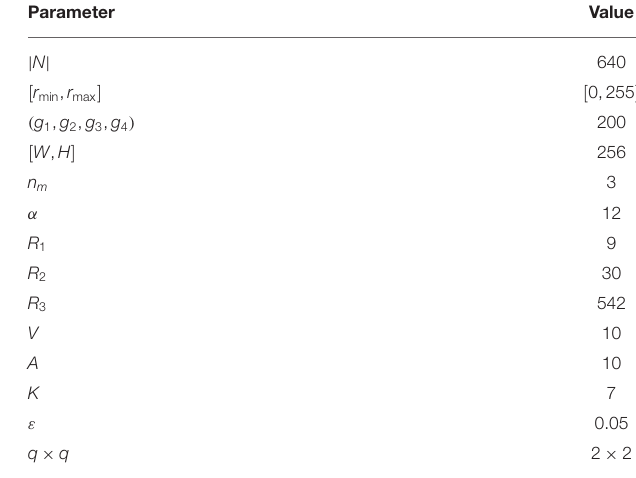
TABLE 5 | Parameters and their